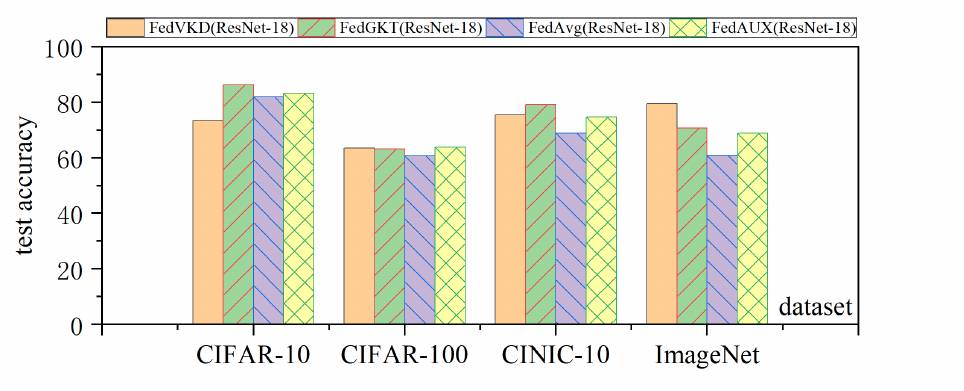
Figure 5. Comparison of the test accuracy of the edge-side model over the four datasets of CIFAR-10, CIFAR-100, CINIC-10,